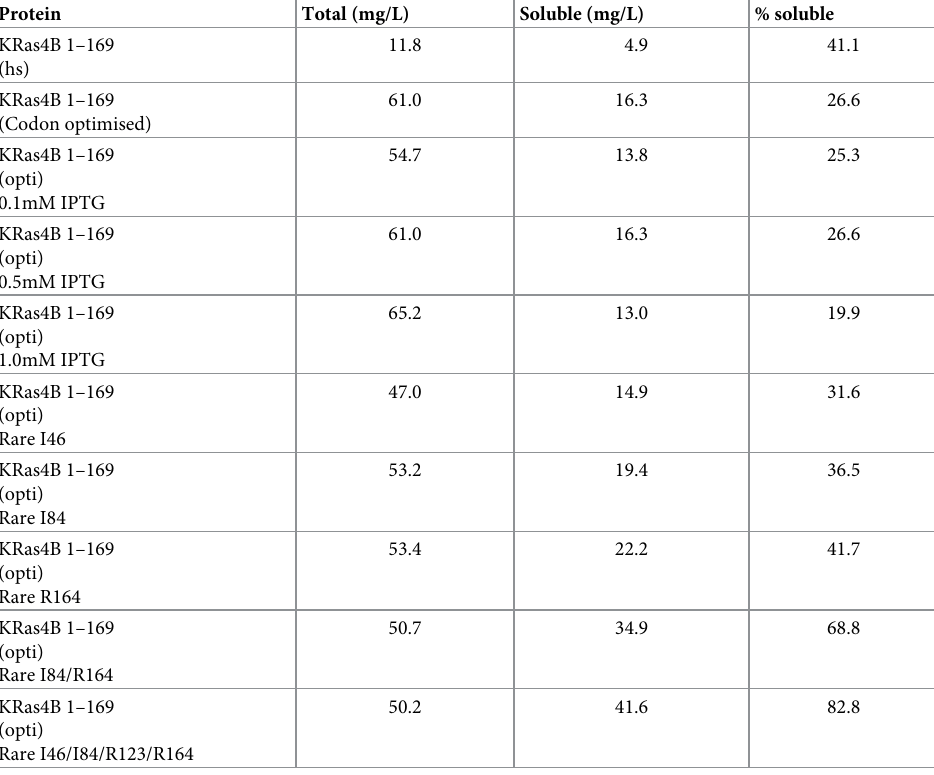
Table 1. Detailed quantification of expression and soluble fraction recovery of a panel of KRas 1–169 expression clones. Protein Total (mg/L) Soluble (mg/L) %